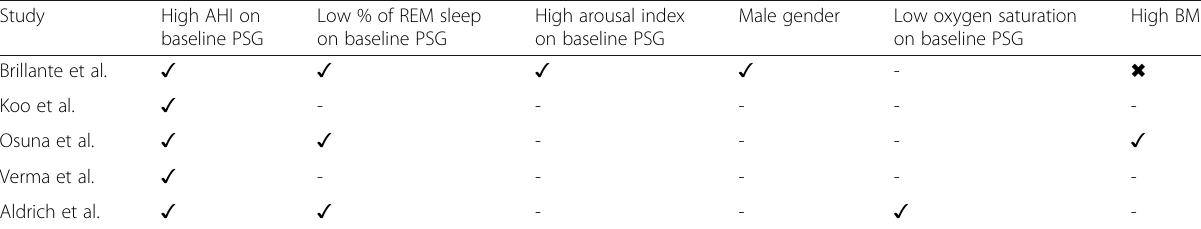
Table 3 Predictive factors for REM rebound on CPAP titration Study